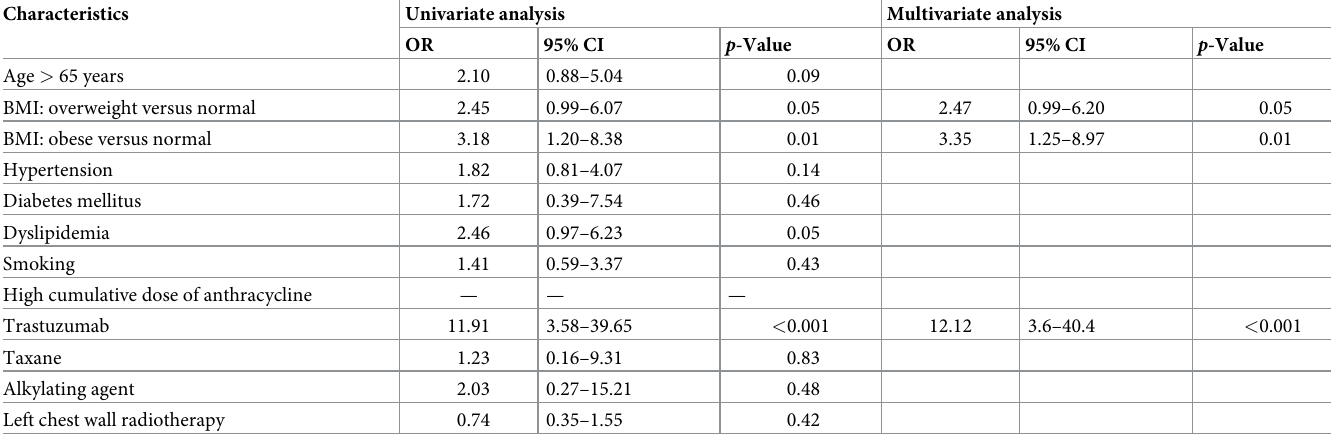
Table 2. Univariate and multivariate analysis of the factors independently associated with cardiotoxicity. Characteristics